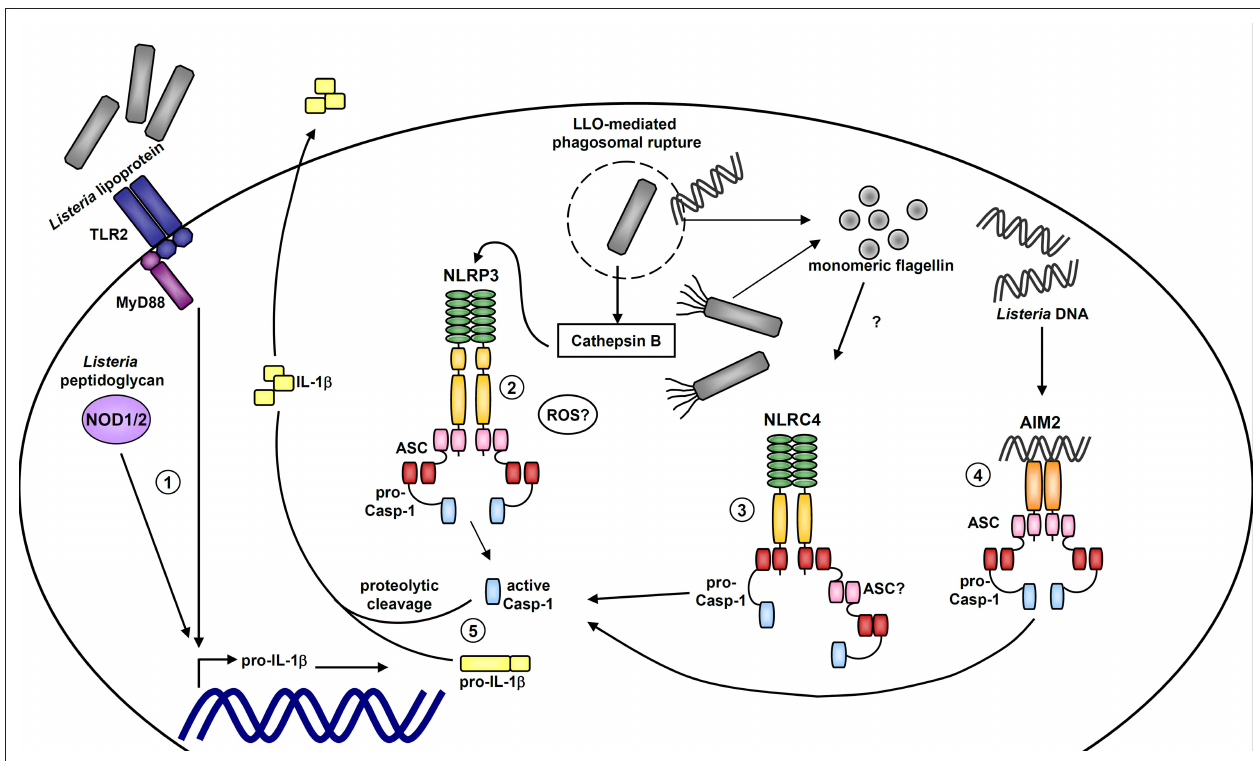
FIgure 2 | Model of inflammasome activation by Listeria monocytogenes. Activation of the extracellular TLR2 pathway via listerial lipoprotein and intracellular detection of bacterial peptidoglycans by NOD1/2 lead to upregulation of pro-IL-1 β transcription (1). After bacterial internalization within a membrane-bound vacuole, listeriolysin O (LLO) leads to phagosomal rupture followed by escape of Listeria into the cytosol as well as cathepsin B release. Lysosomal damage and cathepsin